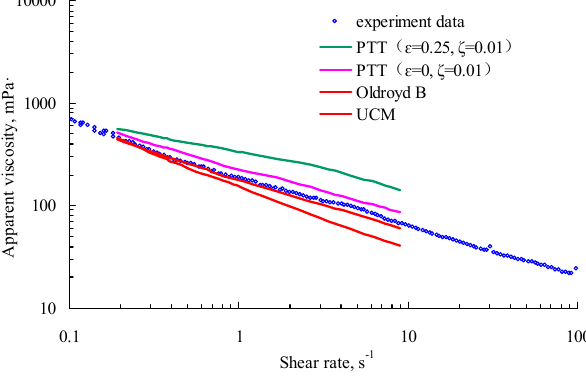
Figure 4. Apparent viscosity matching with shear rate diagram.